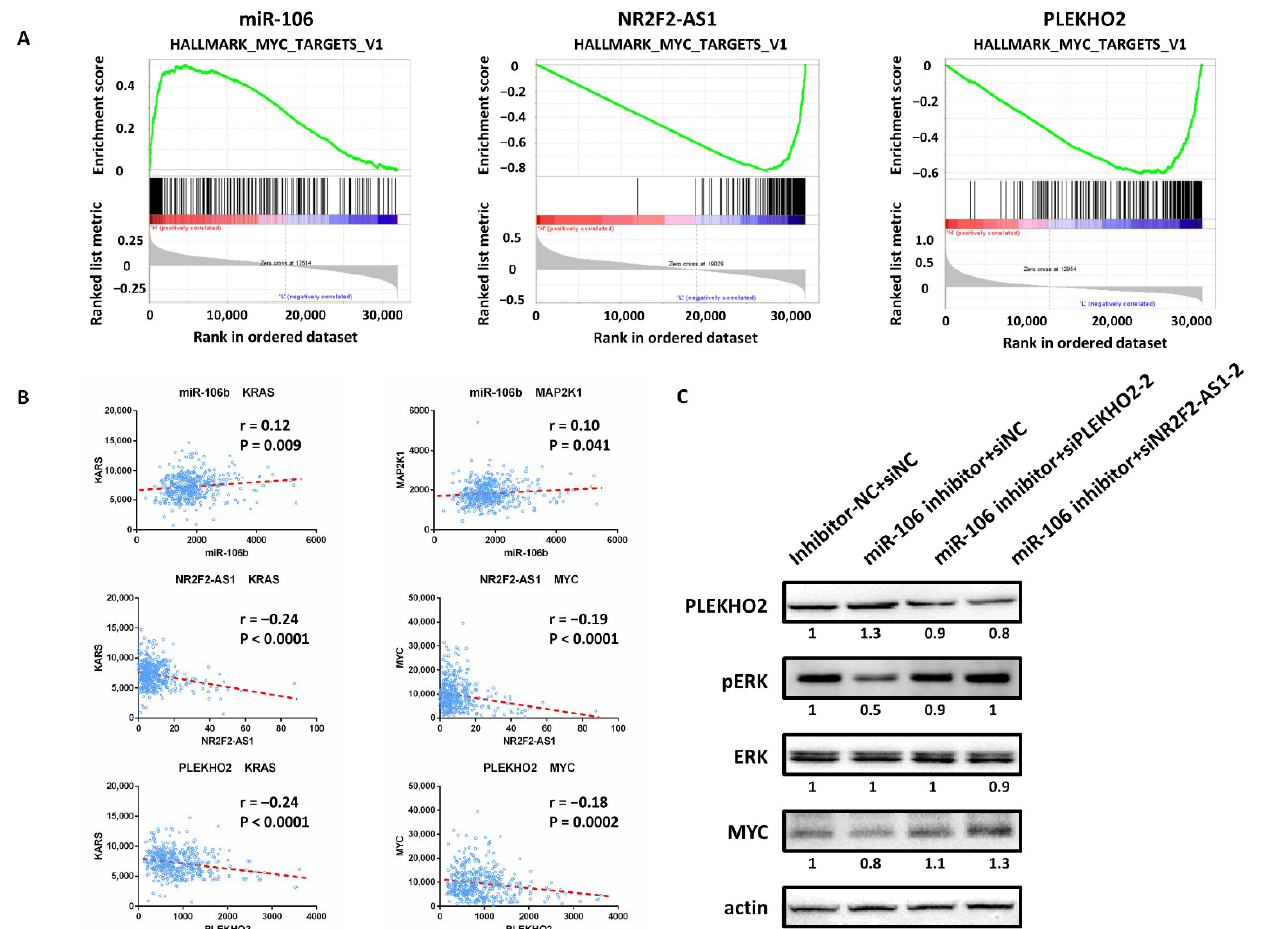
Figure 8. MiR-106b/NR2F2-AS1/PLEKHO2 affect the MAPK pathway in CRC. ( A ) The GSEA results showed a correlation between the levels of MiR-106b/NR2F2-AS1/PLEKHO2 and the MAPK signaling. The gene set “HALLMARK_MYC_TARGETS_V1” is significantly enriched in high levels of mR-106b, but enriched in the low levels of NR2F2-AS1 and PLEKHO2. ( B ) Pearson’s correlation analysis shows that miR-106b is positively correlated with KRAS and MAP2K1. While NR2F2-AS1 and PLEKHO2 are negatively correlated with KRAS and MYC. ( C ) Western blot showed that transfection of miR-106b inhibitor suppresses the phosphorylation of ERK and the protein expression of MYC. Co-tranfection of PLEKHO2 siRNA or NR2F2-AS1 siRNA rescues miR-106b inhibitor-induced expression suppression.